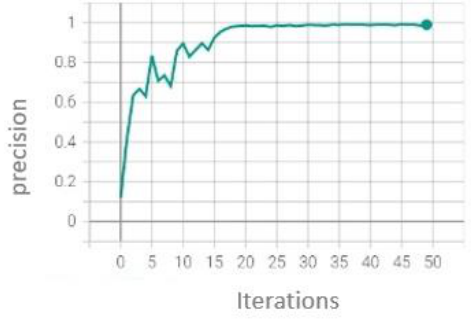
Figure 19. Character recognition training graph.